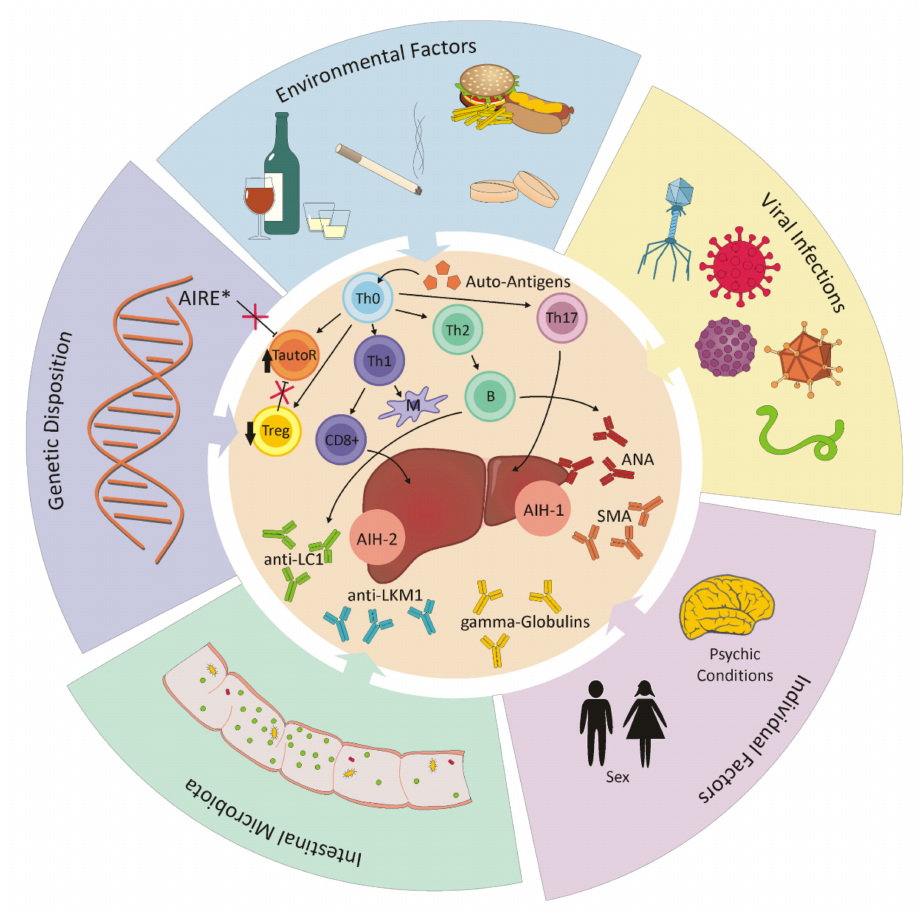
Figure 4. External and intrinsic factors modulating the immune system. Although the causes have not been fully revealed, environmental factors such as diet, alcohol or drug consumption and viral infections, as well as intrinsic factors such as psychic conditions, the patient’s sex, intestinal microbiota and genetic disposition, are supposed to promote the development of autoimmune hepatitis. Independently of age, females are affected 3–4 times more frequently than males. It is supposed that a failure in immune tolerance leads to a CD4 + and CD8 + T-cell-mediated immune attack against liver antigens. A decrease in Treg cells or mutation (*) in the AIRE gene lead to a loss of the homeostasis between autoreactive T cells (TautoR) and other effector CD4+ cells and, furthermore, to the production of gamma globulins and autoantibodies such as ANA and SMA in type 1 autoimmune hepatits and anti-LC1 and anti-LKM1 in type 2 autoimmune hepatitis. Abbreviations (in alphabetical order): AIH-1 = autoimmune hepatitis type 1; AIH-2 = autoimmune hepatitis type 2; AIRE = autoimmune regulator protein; ANA = antinuclear antibodies; anti-LC1 =